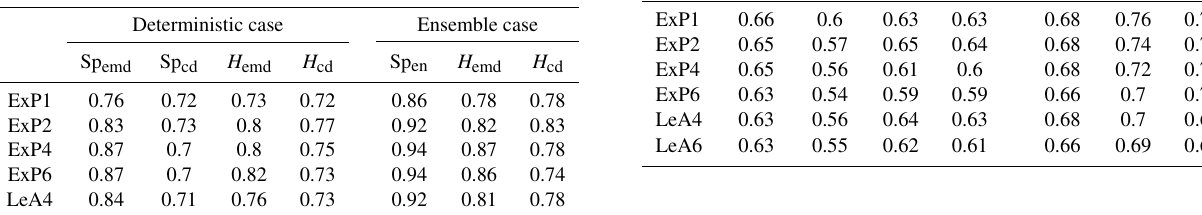
Table 3. Fraction of cases where the correct forecast received the best score for a range of extremal phase (ExP) and least asymmetric (LeA) Daubechies wavelets. LeA4 is the wavelet used for all other experiments in this study; ExP1 is the well-known Haar wavelet.